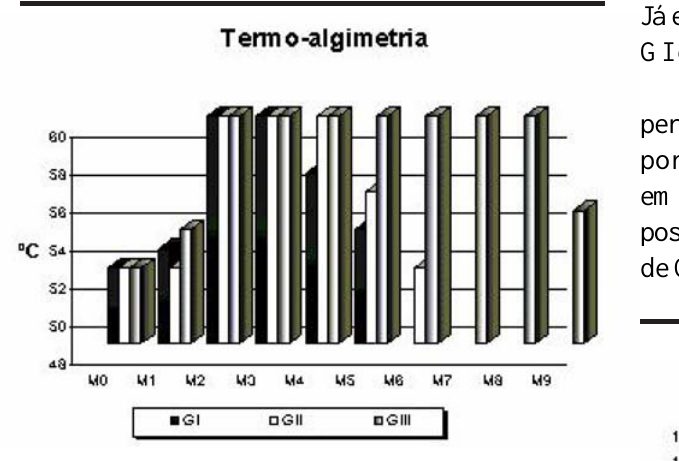
FIGURA 3 – Valores medianos da termoalgimetria em ºC, de cães (n=10), tratados com 1 mg/kg de levomepromazina, 0,2 mg/kg de midazolam e 15 mg/kg de quetamina (GI), pré-tratados com butorfanol (G II) ou pela buprenorfina (G III)